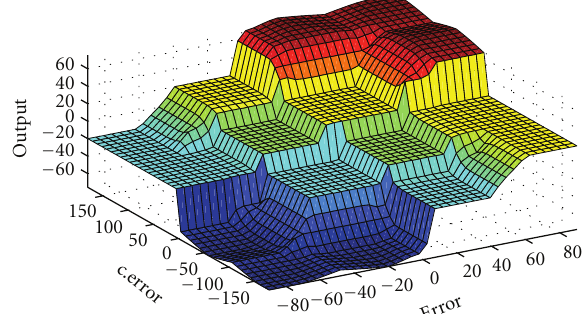
Figure 17: Surface control of the inverted pendulum system.